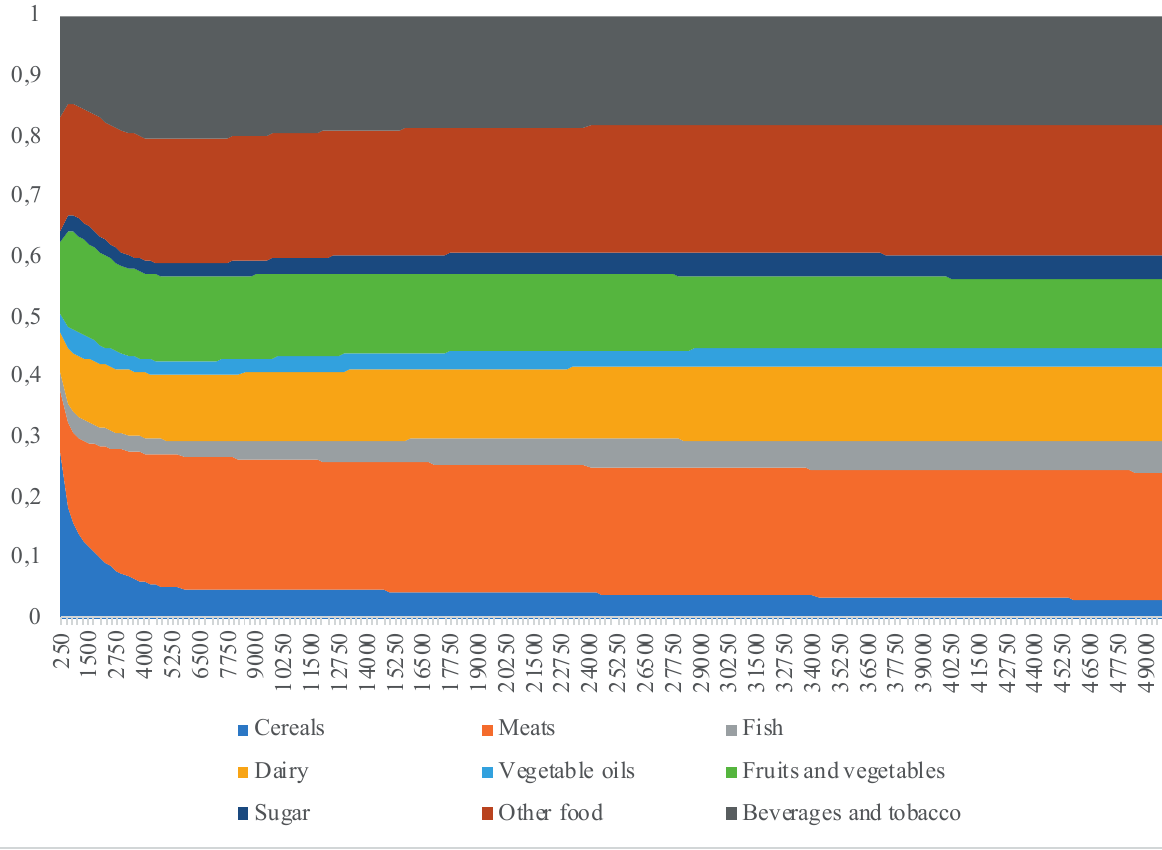
Figure 4. Expenditure shares for food categories. Note: Calculated at mean sample prices and mean sample values of the additional